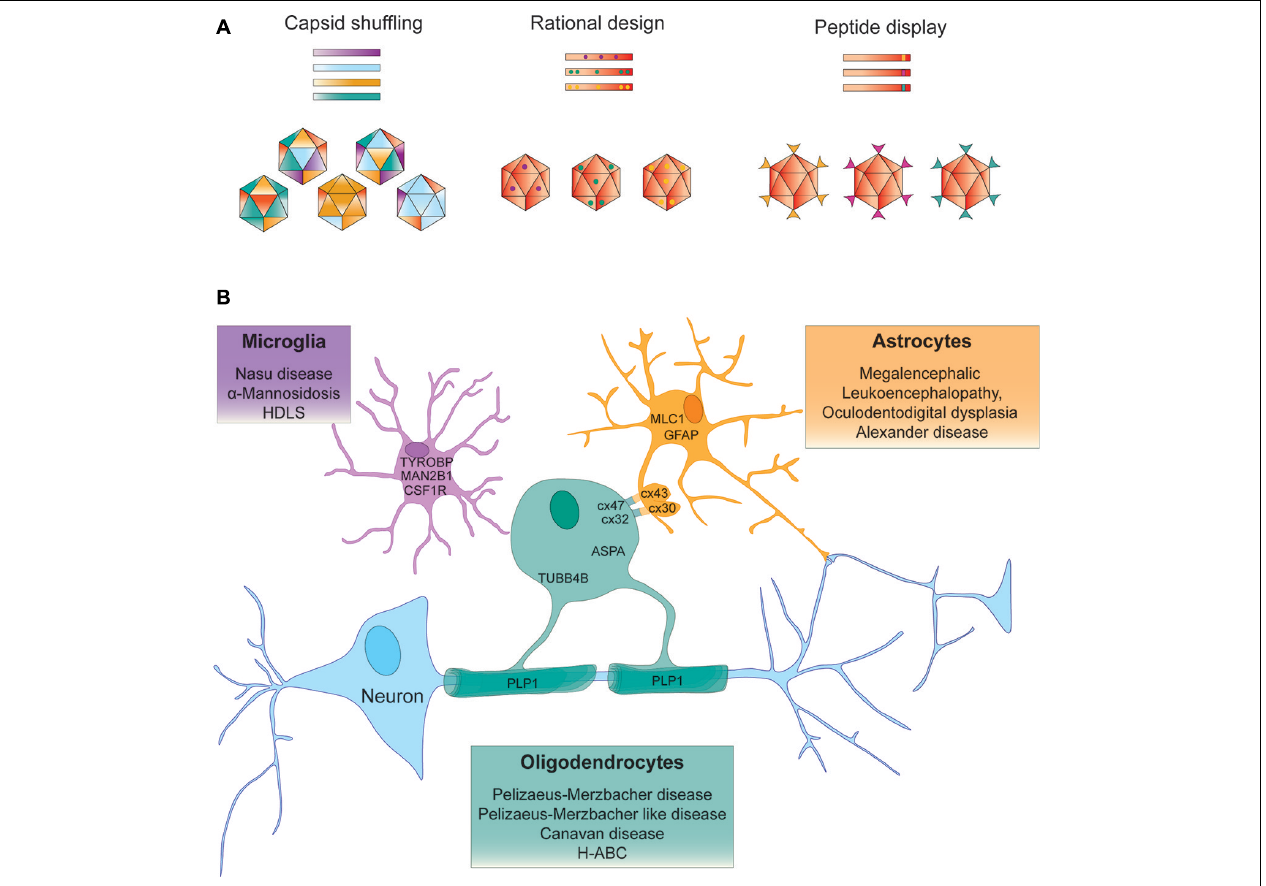
FIGURE 1 | Strategies to identify AAV vectors for AAV – mediated gene targeting to treat leukodystrophies. (A) Capsid shuffling uses capsid DNA from different AAV variants to generate chimeric capsid libraries to be screened for desired biological properties. Rational design relies on prior knowledge of structure – function relationships to transfer a predetermined functional aspect to another vector. Peptide display may incorporate peptides from a randomized library for screening purposes or peptides with known function into the AAV capsid. (B) Examples of leukodystrophy – specific gene targeting approaches that aim to deliver the therapeutic gene to the neural cell type that expresses the disease-causing